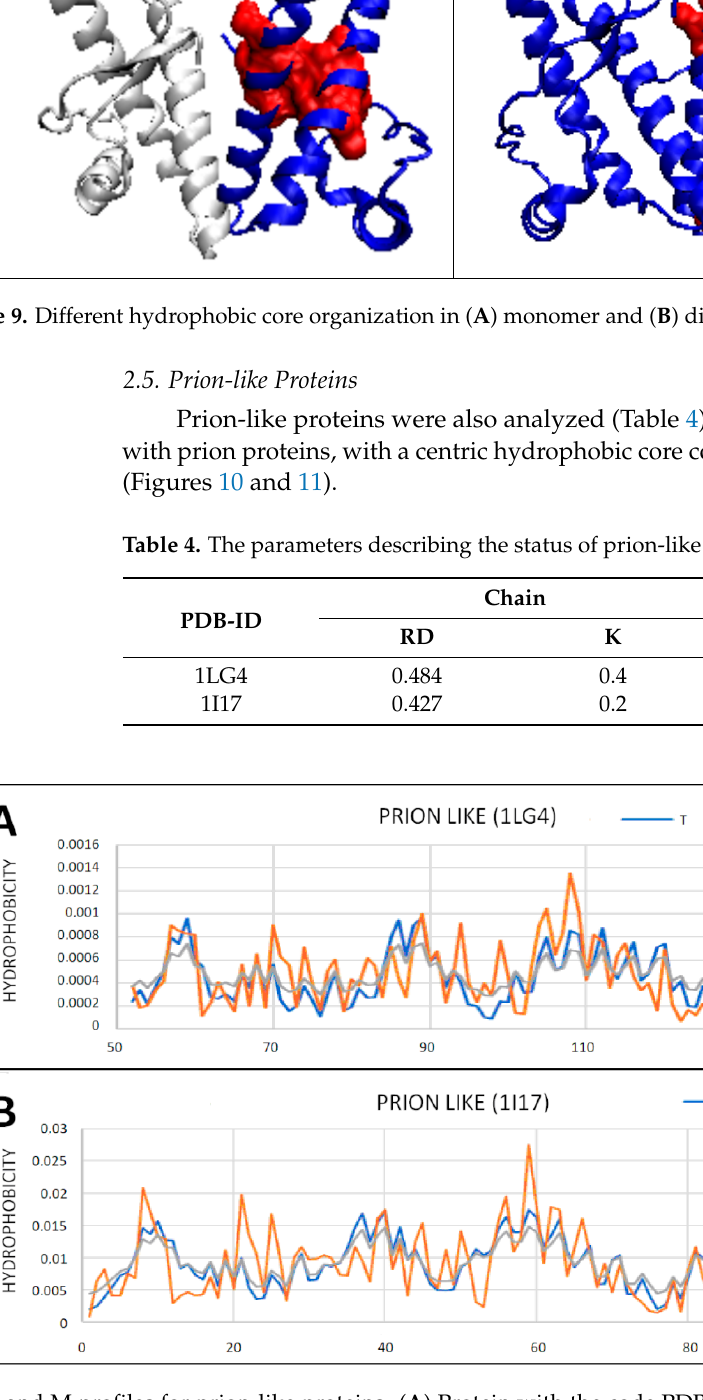
Figure 11. 3D presentation of proteins identified as prion-like. ( A ) 1LG4; ( B ) 1I17. Hydrophobic core marked in red. 2.6. Prion Proteins in Form of Complexes with Fab Fragments of IgG Complexes of prion proteins with a Fab fragment of IgG are also available in the PDB database. This allows one to track changes resulting from interactions with other mole- cules. IgG Fab fragment molecules can be thought of as a target for the prion molecule. At the same time, it is possible to determine the influence of the presence of the Fab fragment of the IgG molecule on the structuring of the prion. With the very distant micelle-like sta- tus of the entire complex, the status of the individually treated prion proteins is not sig- nificantly altered. The changes in the parameters RD and K are observed depending on the composition of the interface. The protein itself maintains its close to micelle-like ar- rangement slightly above the RD threshold (RD > 0.5). Low values of the K parameter for prion proteins as components of the complex treated as individual structural units (3D Gauss function generated individually for the prion protein) indicate a relatively low de- gree of disturbance of the micelle-like system (Figures 12–14).